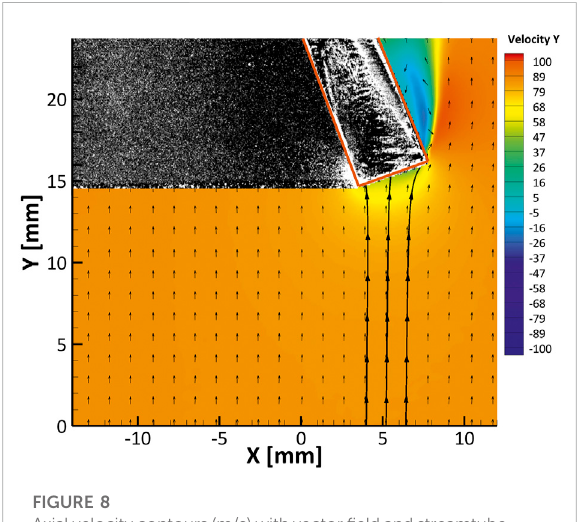
FIGURE 7 Axial velocity contours (m/s) with vector fi eldand streamtube overlaid on image of probe to show approximate location for the M = 0.25, θ = 0 ° test case. Sampling probe boundaries are highlighted in red.